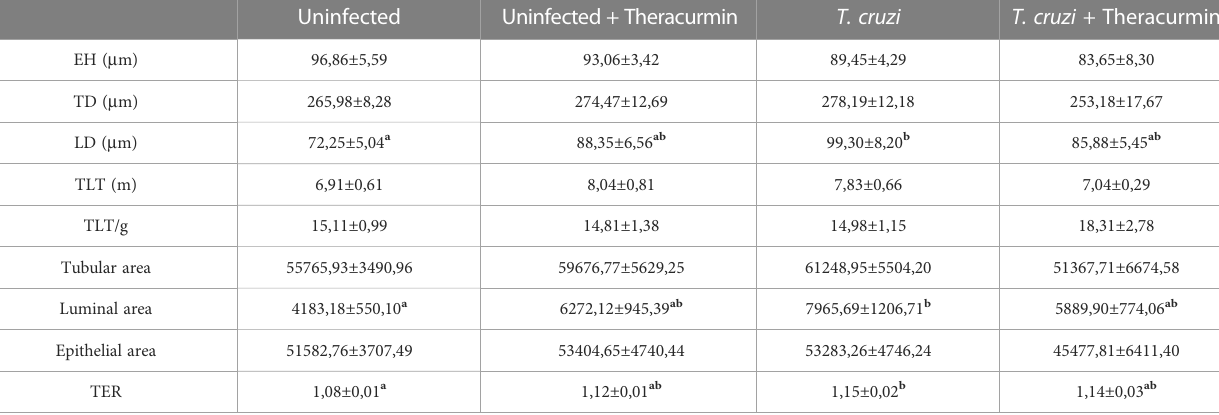
TABLE 3 Stereological analysis of the tubules seminiferous of Swiss mice infected with T. cruzi and treated with